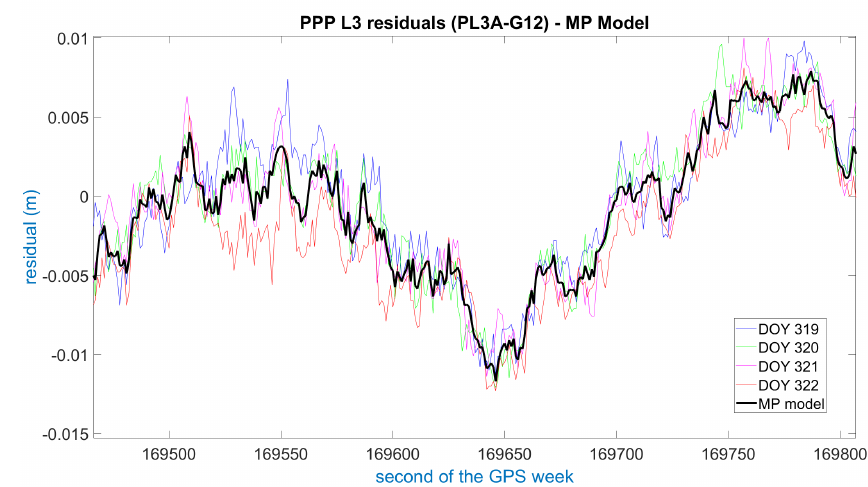
Figure 5. Example of Precise Point Positioning (PPP) residuals from four consecutive days after matching using azimuth and elevation. The GPS time is referred to the first day (2016 DOY 319). The obtained multipath model is shown in